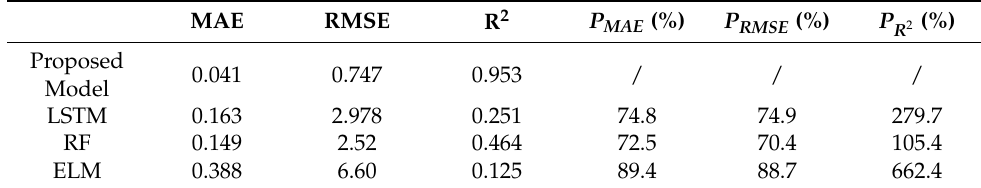
Figure 11. Comparison of total prediction results of measuring point EX5. (( a ) prediction results; ( b ) prediction residuals; ( c ) boxplot of residuals). Table 6. Comparison of evaluation indexes of measuring point Table 5. Comparison of evaluation indexes of measuring point EX5.